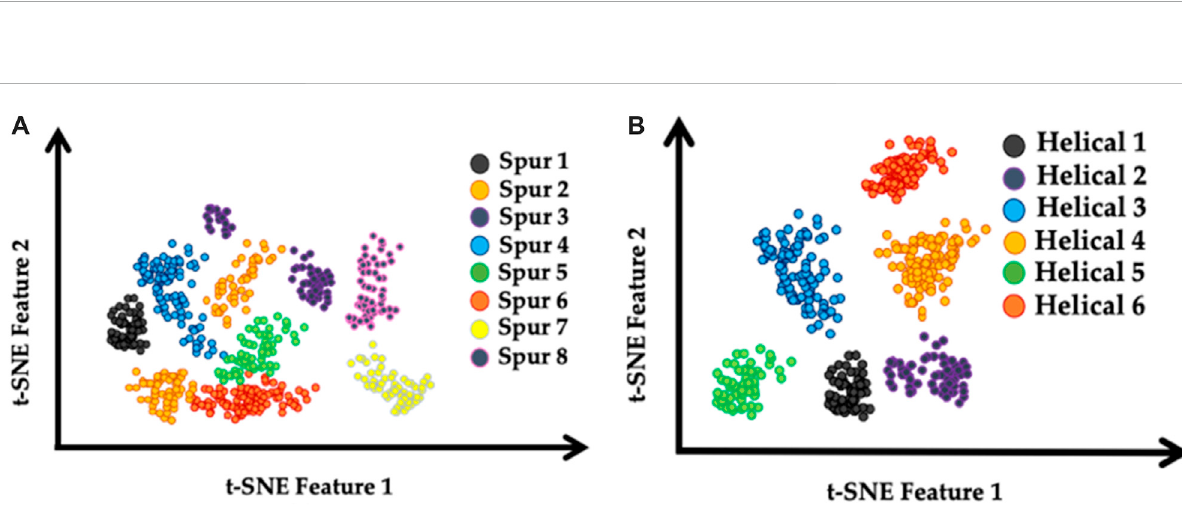
FIGURE 6 The scatter plots of the t-SNE features: (A) Subtask 1, (B) Subtask